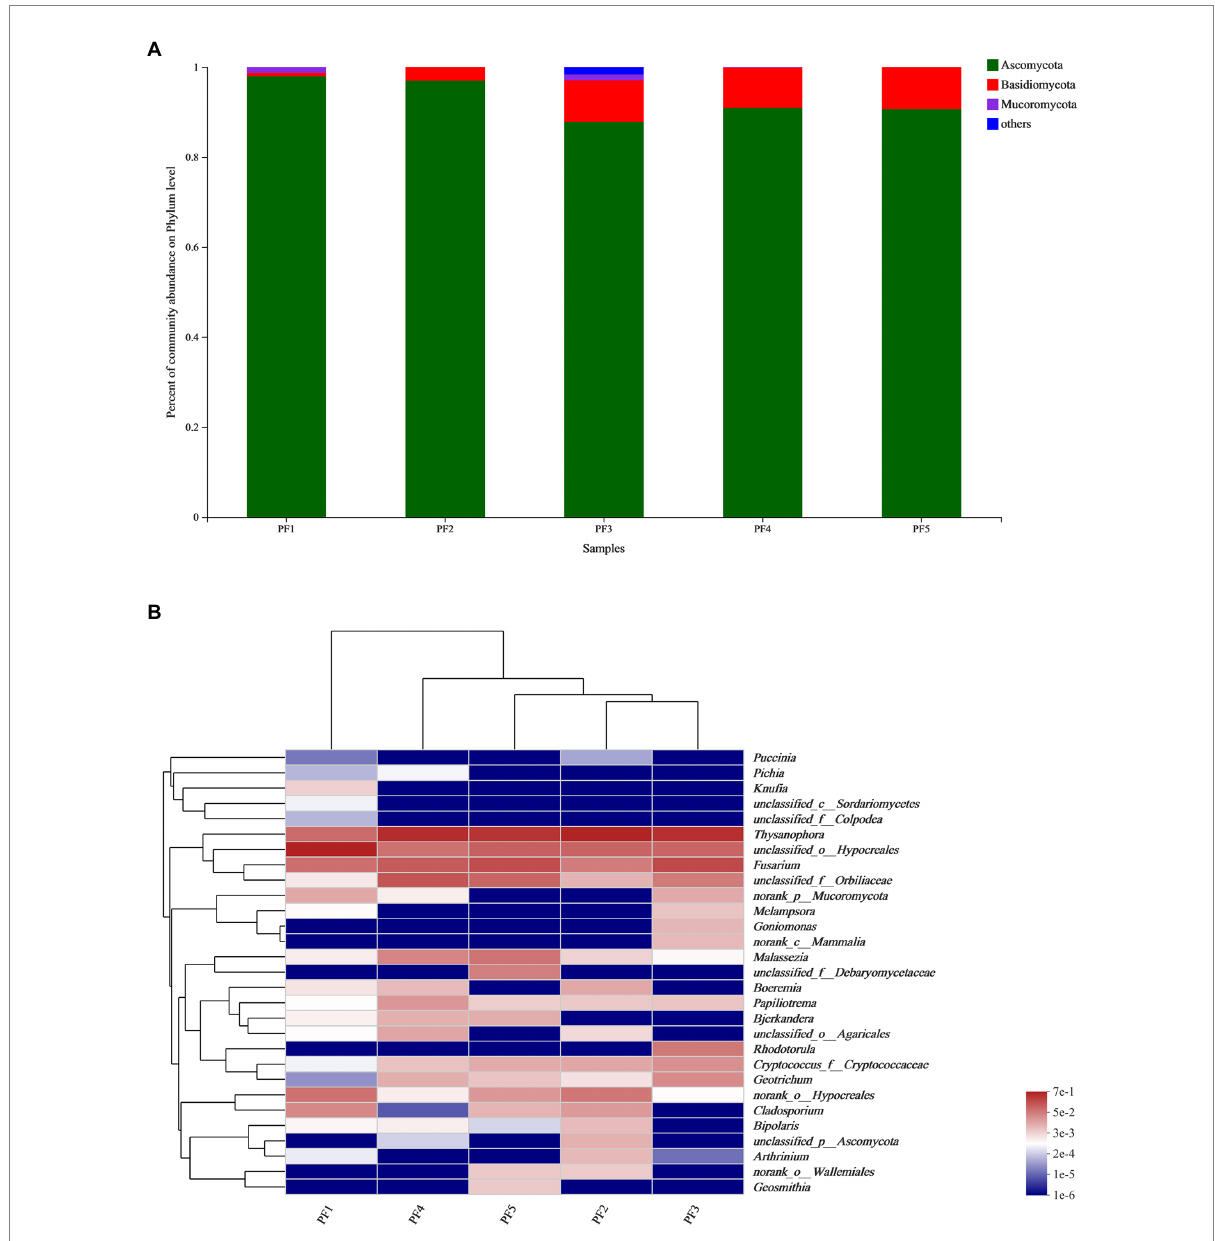
FIGURE 3 Fungal community analysis. (A) Histogram of species relative abundance of the pottery figurines at the phylum level; (B) Heatmap at the genus